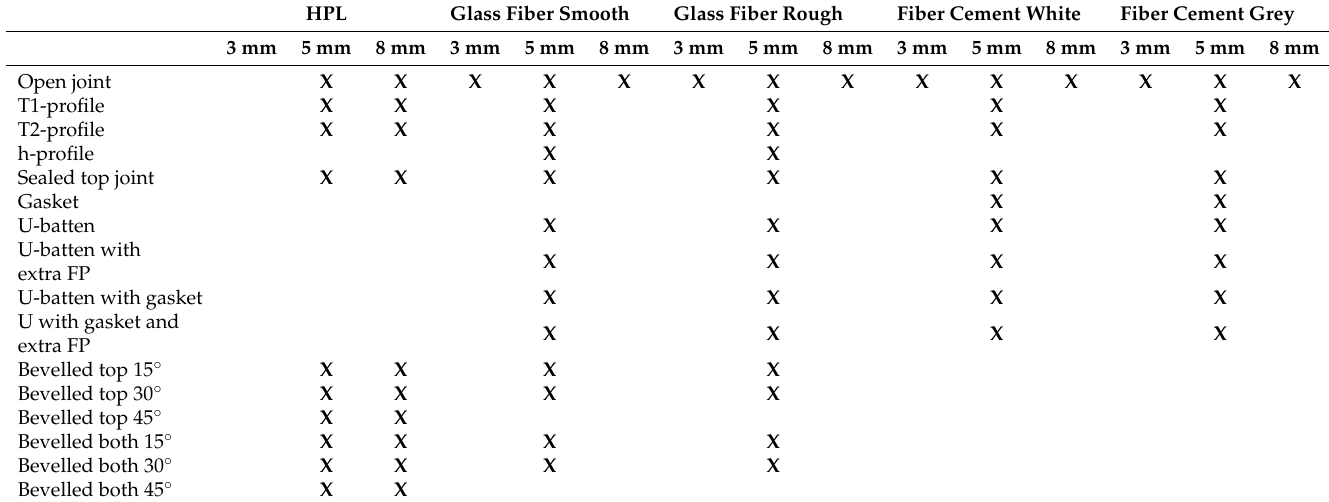
Table 2. Overview of combination of test parameters conducted during the laboratory measurements. (FP is an abbreviation of “fastening points”).